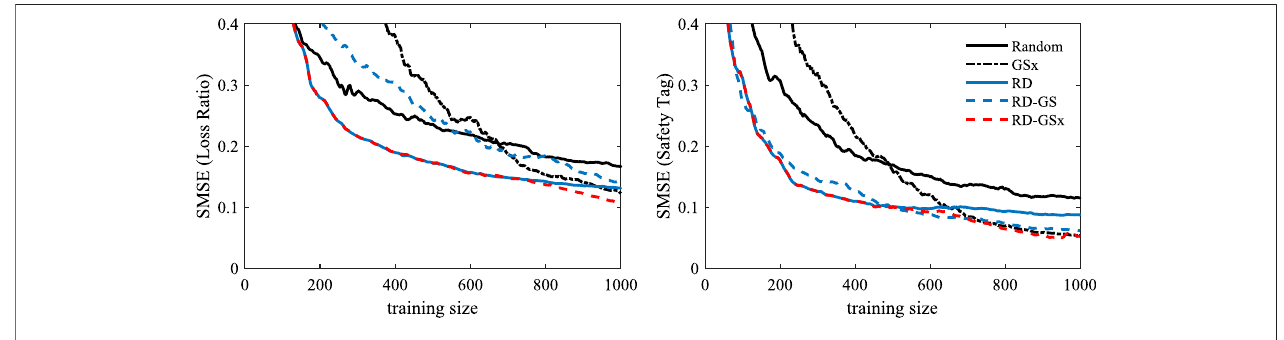
FIGURE 8 | Comparison of sampling methods based on the improvements in